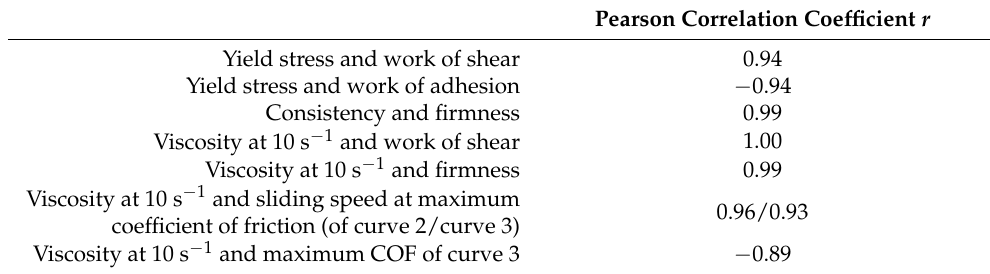
Table 7. The Pearson correlation coefficient between various results of the experimental